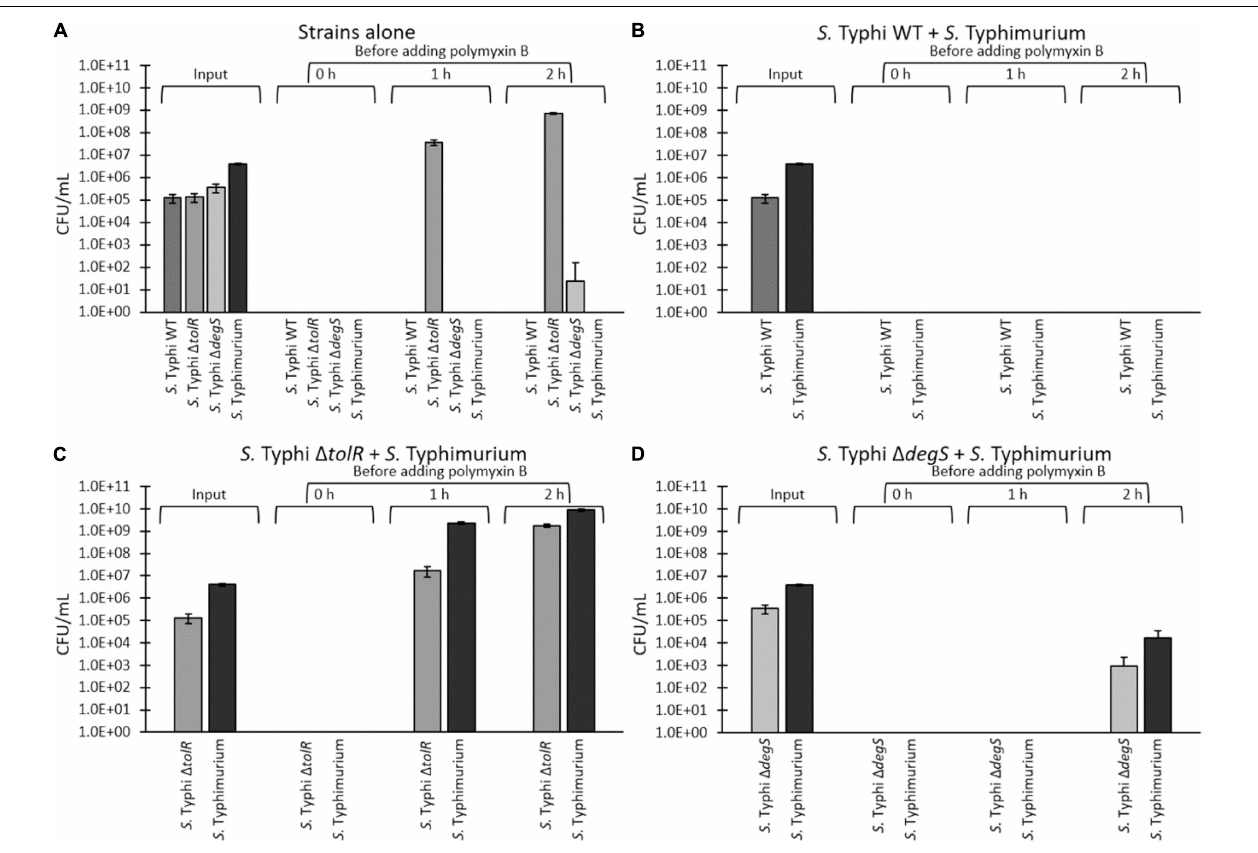
FIGURE 6 | “One for all” assay of a challenge with 2.5 µ g/mL polymyxin B. S. Typhi WT, (cid:49) tolR , (cid:49) degS, and S . Typhimurium ompD ::Mu d- J (Lac + ) were washed and diluted in LB to remove OMVs, and incubated in LB at 37 ◦ C with shaking for 0, 1, or 2 h at 37 ◦ C to allow OMVs accumulation, before adding polymyxin B (final concentration of 2.5 µ g/mL, corresponding to 8 times the MIC of S. Typhi WT). Bacteria were incubated with polymyxin B overnight at 37 ◦ C with shaking prior to determining the CFU/mL (output). (A) Strains were challenged separately. (B) S. Typhi WT and S. Typhimurium ompD ::Mu d- J were mixed (1:10) before the challenge. (C) S. Typhi (cid:49) tolR and S. Typhimurium ompD ::Mu d- J were mixed (1:10) before the challenge. (D) S. Typhi (cid:49) degS and S. Typhimurium ompD ::Mu d- J were mixed (1:10) before the challenge. To determine the CFU/mL, bacteria were plated onto LB supplemented with X-gal (white colonies: S. Typhi WT or derivatives, blue colonies: S. Typhimurium ompD ::Mu d J). Alternatively, the serovar was corroborated by a PCR for the SPI-18 as previously described (Fuentes et al., 2008). (In all cases, n = at least 4).